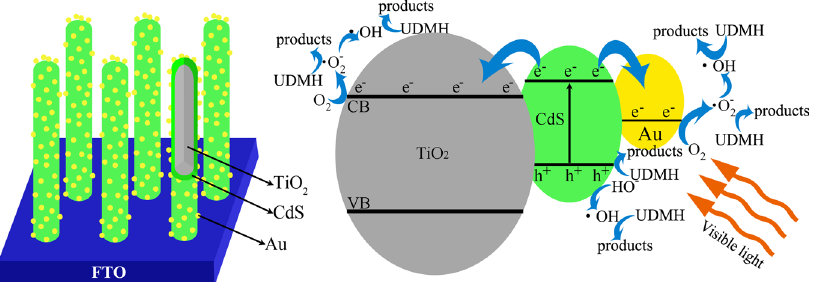
Figure 8. Schematic of carriers transfer and degradation process of UDMH for TiO 2 NRAs/CdS/Au under visible